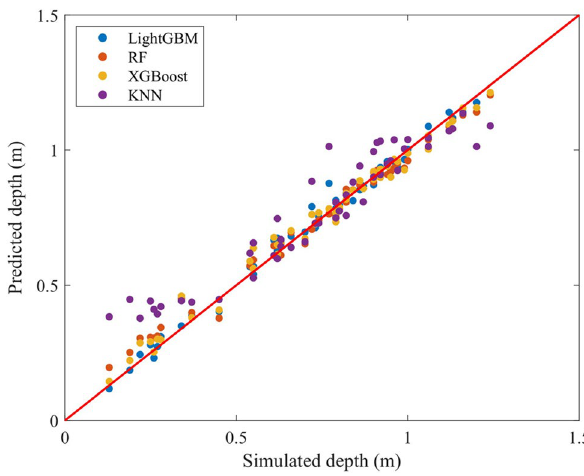
Fig. 15 Comparison of simulated water depth from the personal com- puter storm water management model (PCSWMM) with predicted water depth from light gradient boosting machine (LightGBM), ran- dom forest (RF), extreme gradient boosting (XGBoost), and k-nearest neighbor (KNN) at the 10 flooded points in the Haidian Island study area on Hainan Island, China during Typhoon Rammasun on 18 July